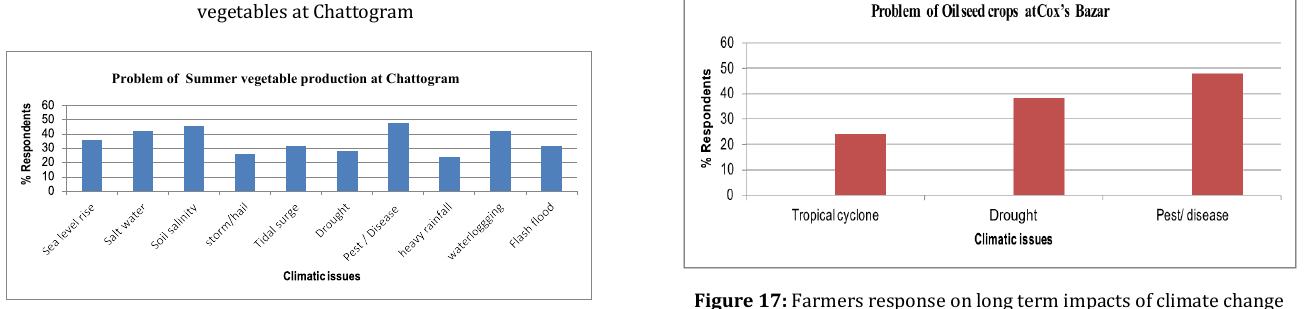
Figure 13: Farmers response on impacts of climate change on summer